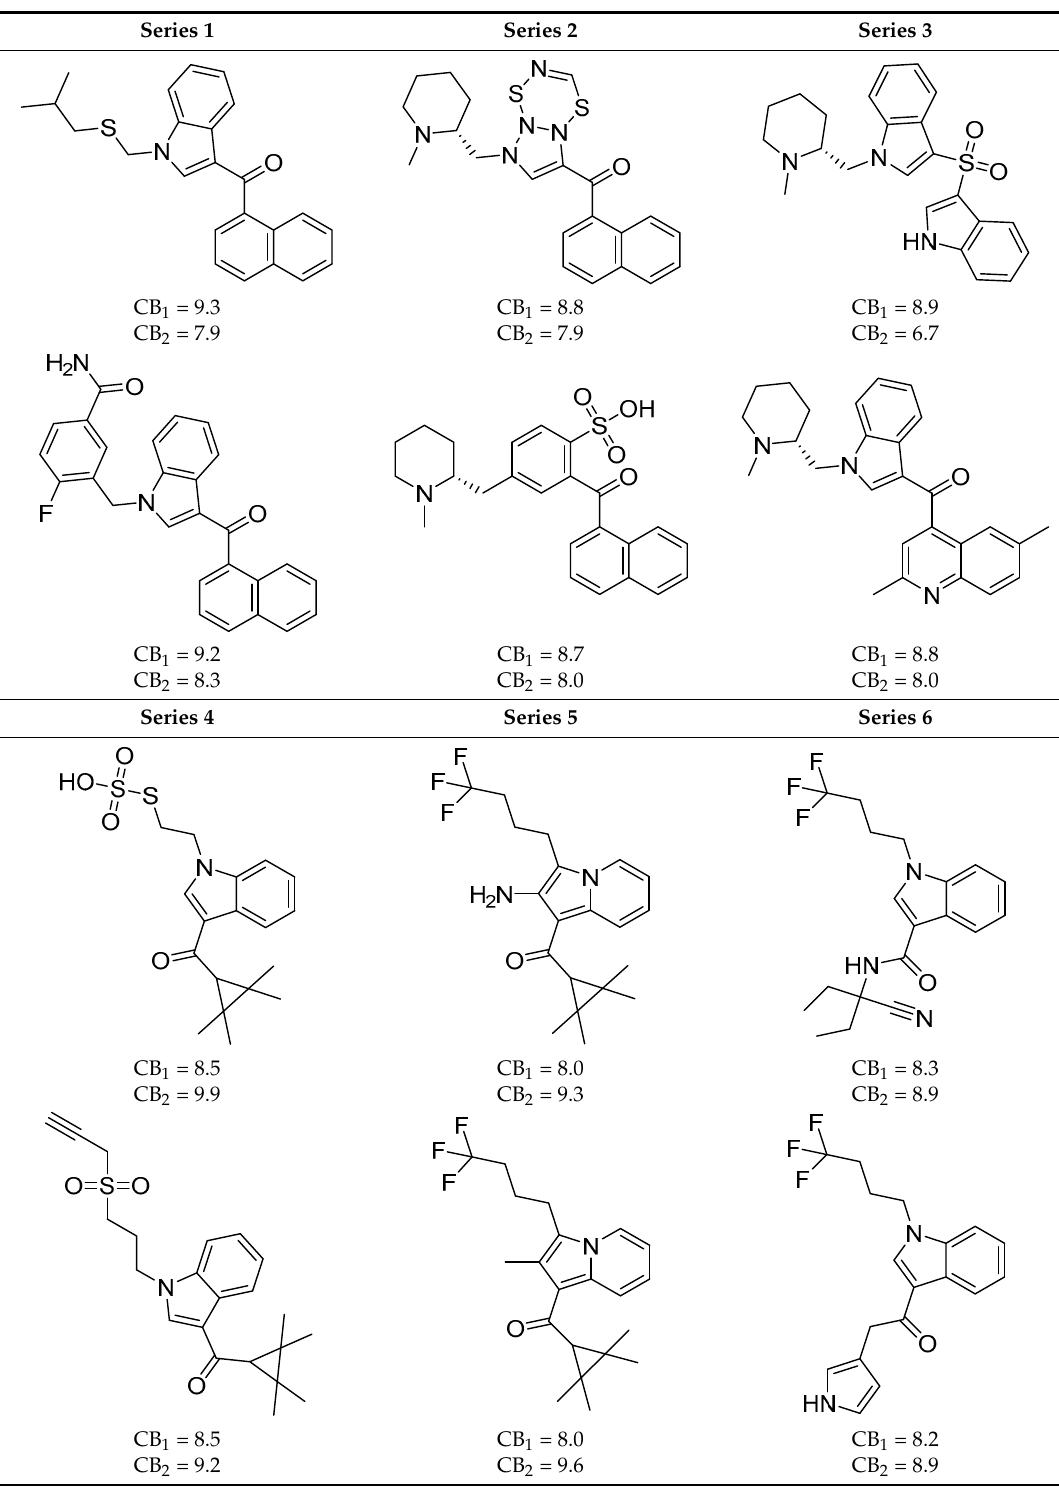
Table 1. Chemical structures of the most potent compounds derived from the bioisosteric replacement for the CB 1 receptor, the predicted K i value are presented as p K i .